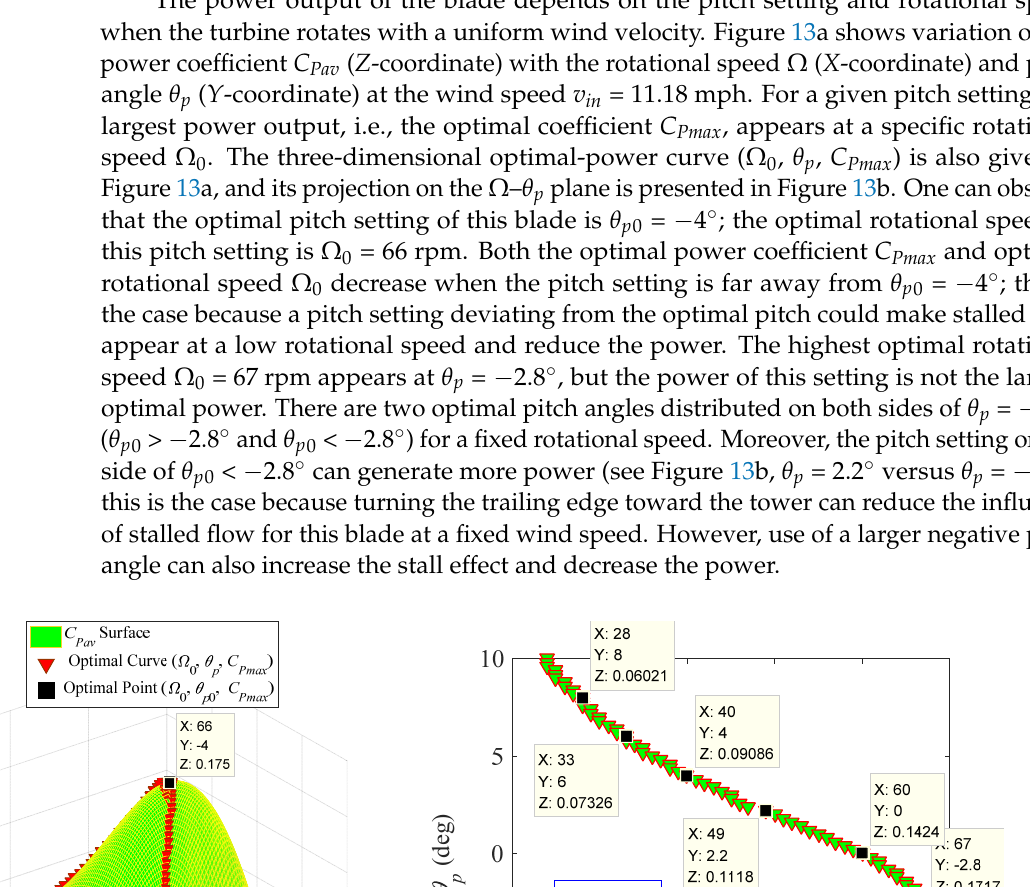
Figure 14. Optimal curve of the power coefficient C p max at different wind speeds.